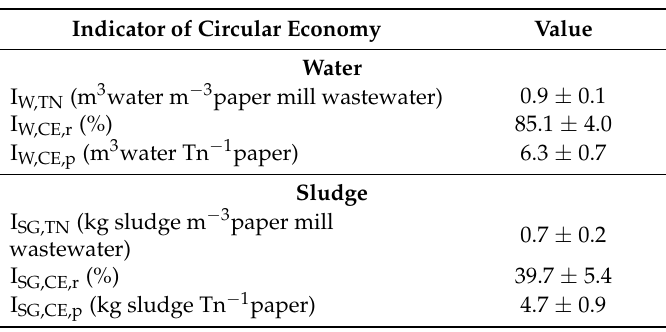
Table 3. Indicators of technological nutrient performance and circular economy efficiency for water and sludge produced during the process of wastewater treatment of the paper mill. I W,TN (indicator of technological nutrient performance for water), I W,CE,r (reductive indicator of circular economy efficiency for water), I W,CE,p (productive indicator of circular economy efficiency for water), I SG,TN (indicator of technological nutrient performance for the recovered sludge), I SG,CE,r (reductive indicator of circular economy efficiency for sludge), I SG,CE,p (productive indicator of circular economy efficiency for